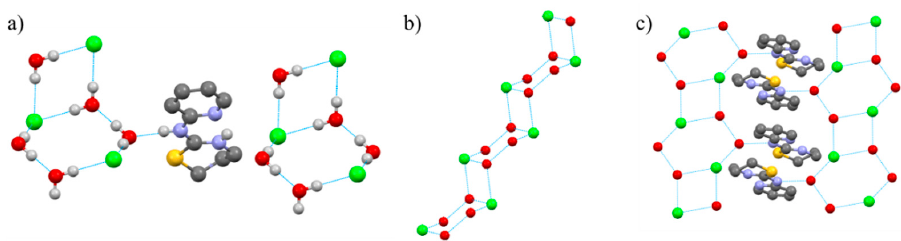
Figure 2. ( a ) Intermolecular hydrogen bond system in the crystal structure of PyTzHCl·2H 2 O. ( b ) Conformation of {[(H 2 O) 5 Cl 3 ] 3 − } n tapes in the PyTzHCl·2H 2 O crystal structure. ( c ) Supramolecular structure of PyTzHCl·2H 2 O.